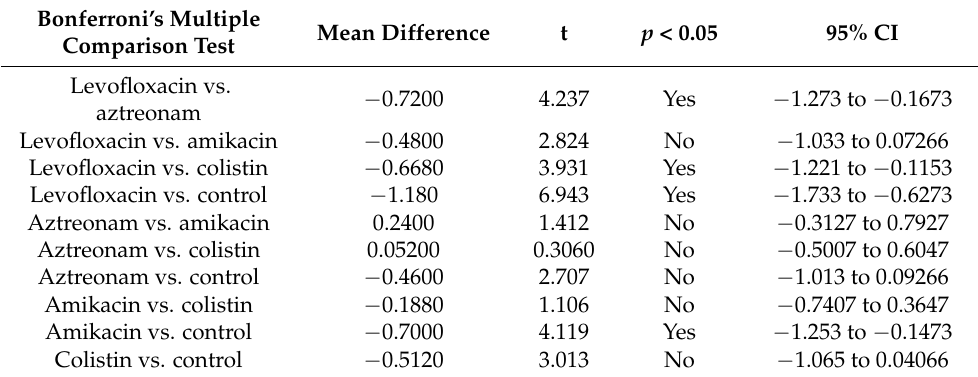
Table 2. One-way ANOVA effects of different antibiotics on LOX